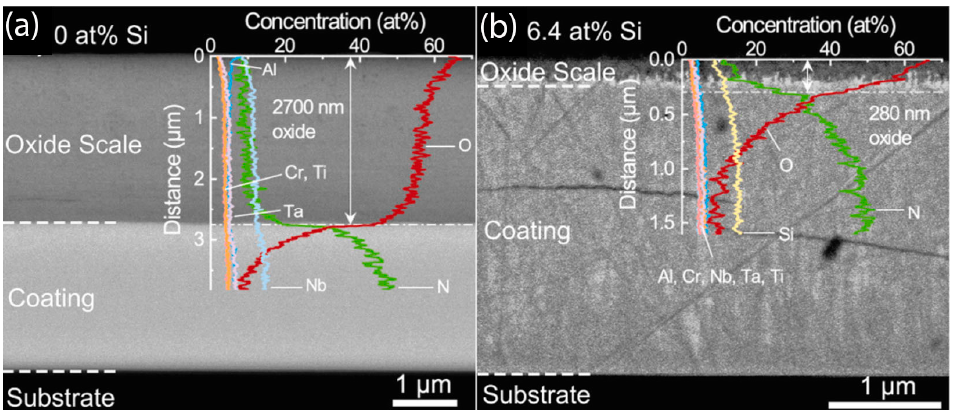
Figure 6. SEM cross-section of the (AlCrNbTaTi)N without Si ( a ) and with 6.4 at.% Si ( b ) after exposure to ambient air at 850 °C for 100 h. Figure reproduced with permission [17]. Copyright 2021 Surface and Coatings Technology (open